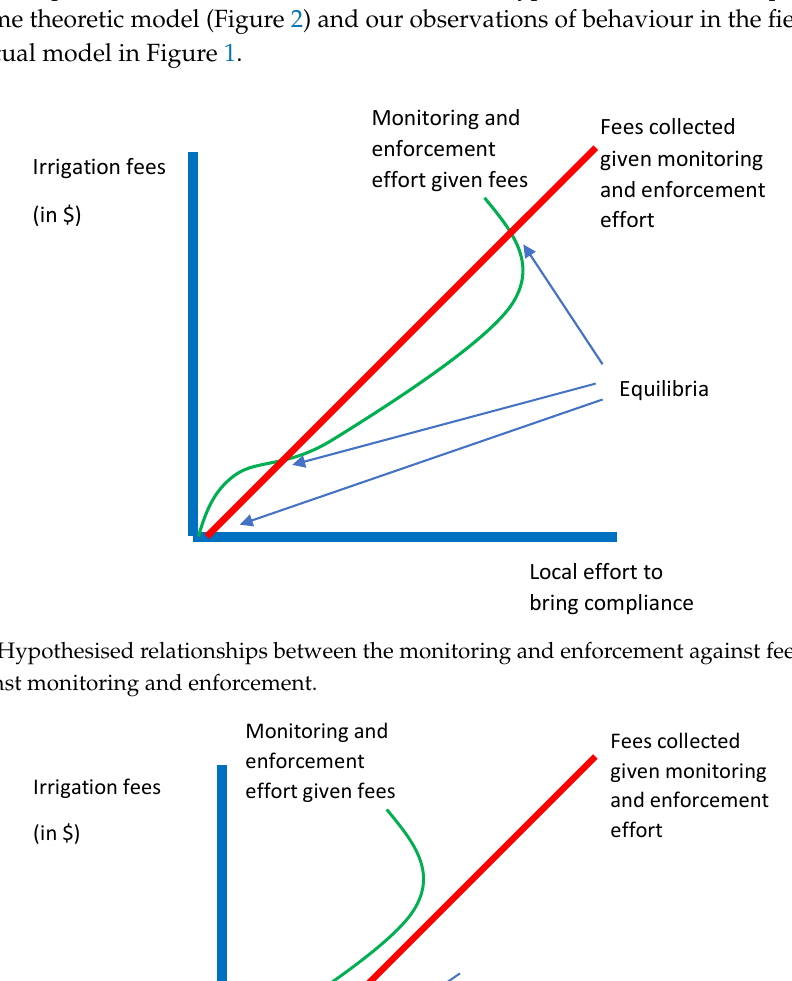
Figure 3. Hypothesised relationships between the monitoring and enforcement against fees paid/fees paid against monitoring and enforcement.